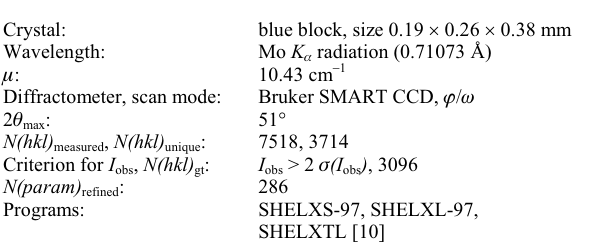
Table 1. Data collection and